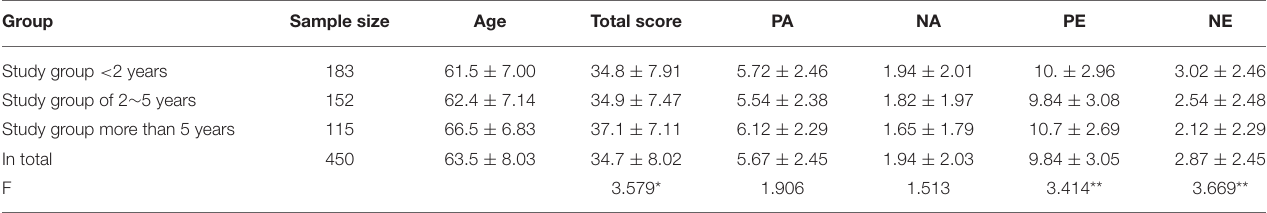
TABLE 5 | The score of four factors between the piano learning groups and the comparison of the differences between the groups. Group Sample size Age Total